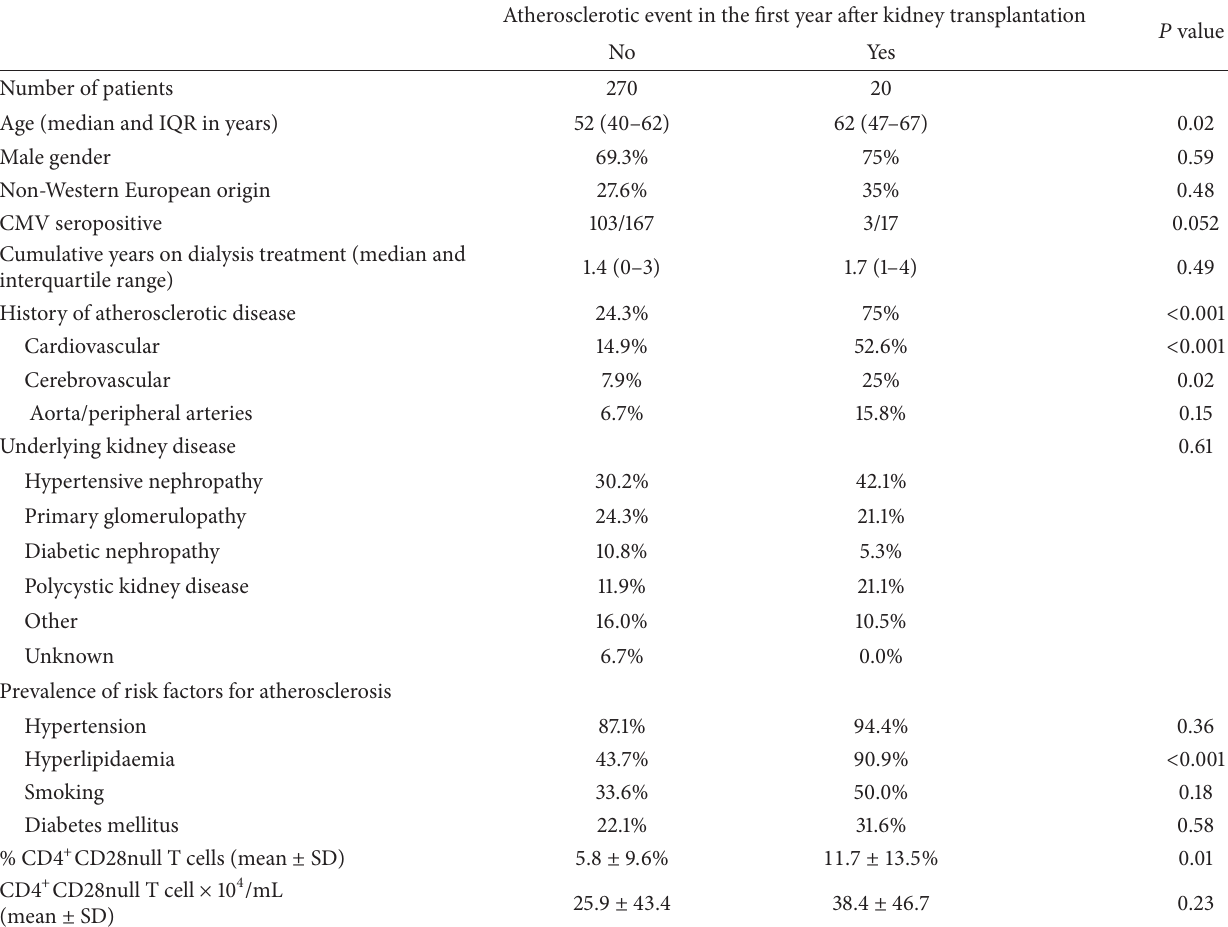
Table 1: Demographic and clinical characteristics of patients receiving a kidney allograft with or without an atherosclerotic vascular event in the first year after transplantation.